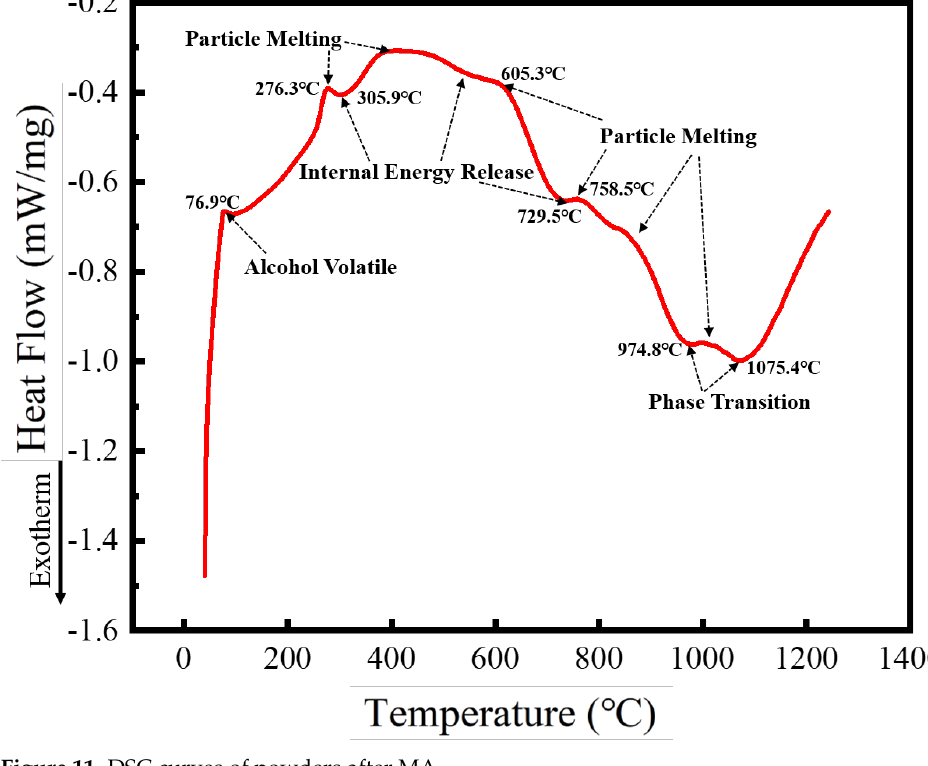
Figure 11. DSC curves of powders after MA.